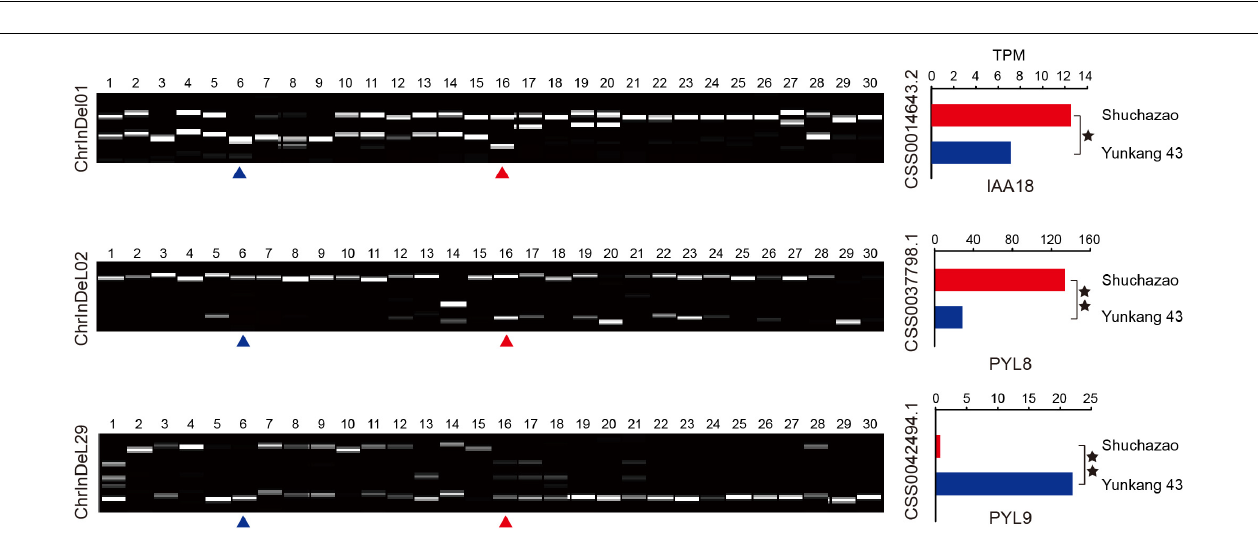
FIGURE 6 | Exhibition of transferability and polymorphism of three hormone-related indel markers among 30 tea varieties. Code 1 ∼ 15 and code 28 represent CSA varieties, others represent CSS varieties. Blue arrow and red arrow represent “Yunkang 43” and “Shuchazao” varieties, respectively. TPM (Transcripts Per Kilobase of exon model per Million mapped reads) represents the expression level of the gene they are located in.